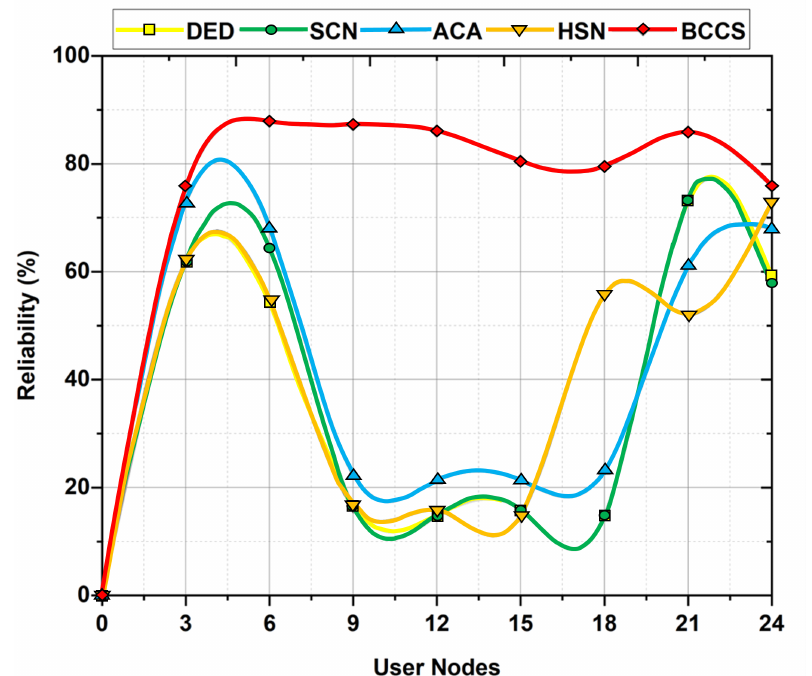
Figure 6. Reliability (user